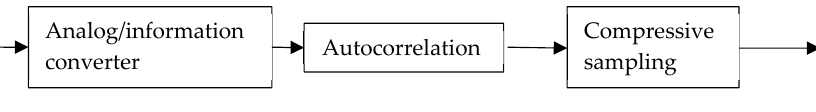
Figure 11. Concept of compressive sensing as introduced in [64].